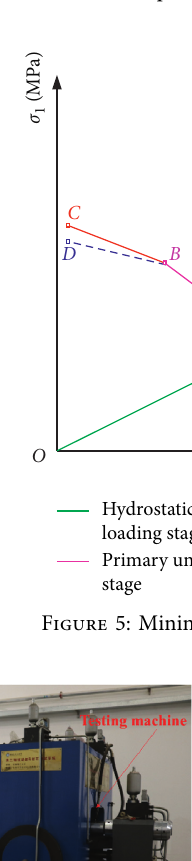
Figure 4: Stress environment in front of stope in the mining face under different protective layer mining modes.